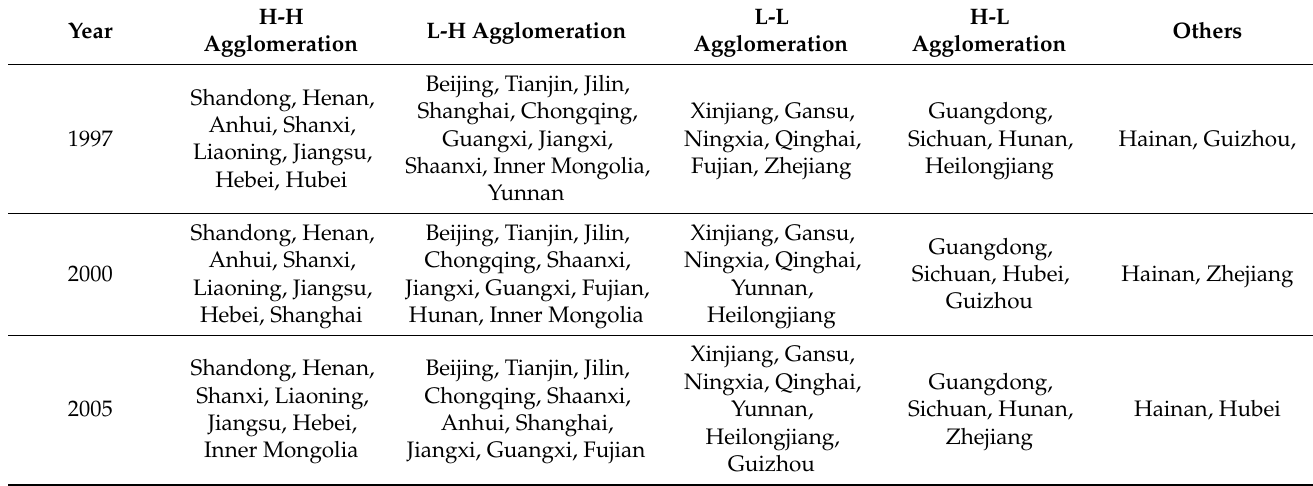
Table 15. The spatial agglomerations of China’s 30 provinces in 1997, 2000, 2005, 2010, and